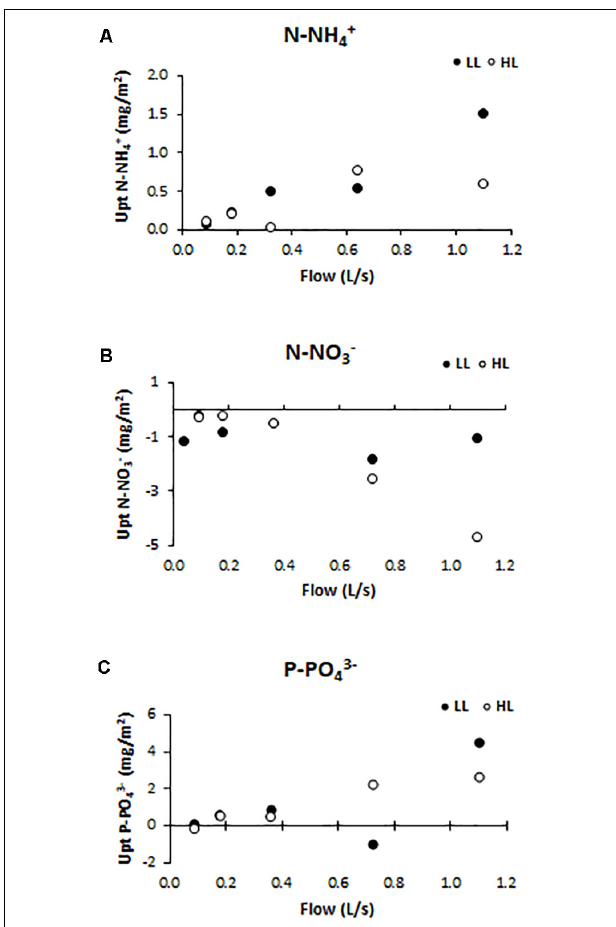
FIGURE 5 | Uptake/release capacity values for different treatments: (A) ammonium (mg N-NH + 4 /m 2 ), (B) nitrate (mg N-NO − 3 /m 2 ), and (C) phosphate (mg P-PO 3 − 4 /m 2